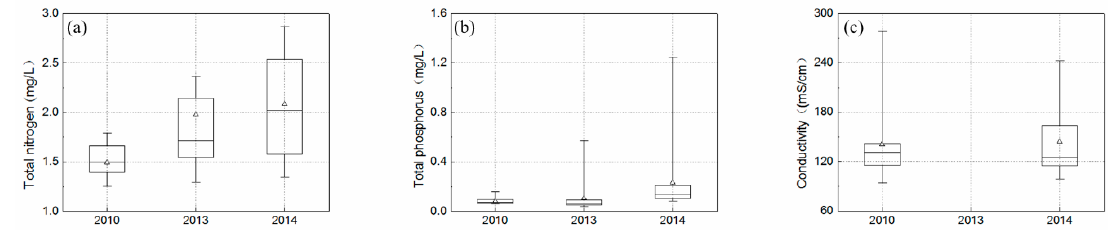
Figure 5. Variation of total nitrogen ( a ), total phosphorus ( b ) and electrical conductivity ( c ) in 2010, 2013, and 2014. The maximum, 75th, mean, 25th, and minimum percentile are included in the boxplot.